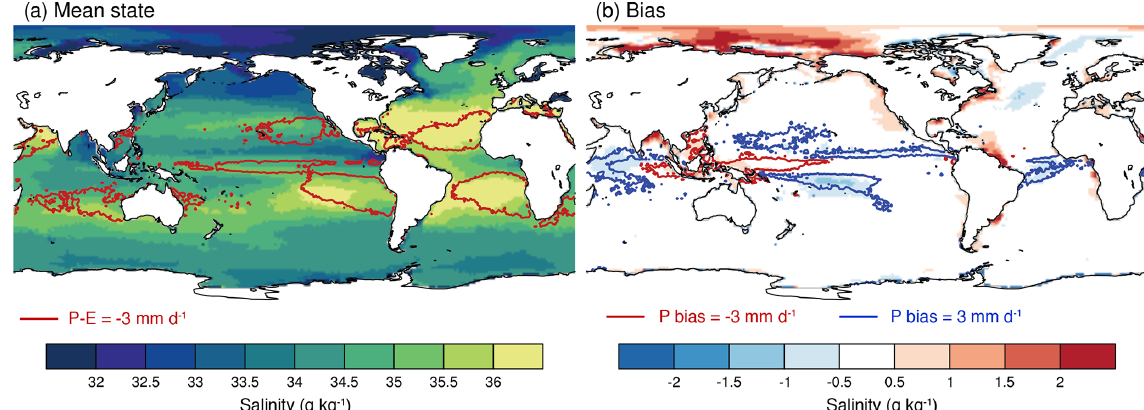
Figure 7. Salinity (gkg − 1 ) from G_AO_5km as (a) a temporal mean and (b) bias relative to observations overlaid with contour lines repre- senting P − E in (a) and precipitation bias in (b) . Observations from PHC (grid spacing of 1 ◦ ) for salinity and from GPCP for precipitation. For G_AO_5km, the time period 1 March 2020 to 28 February 2021 is considered.